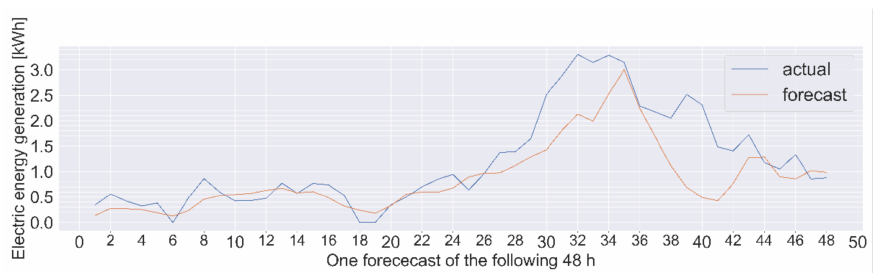
Figure 15. Forecast of electric energy generation from 1 to 48 h made by MLP_INT [PHM+LSTM, PHM+MLP PSO , PHM+KNNR] method for two following days of the spring month